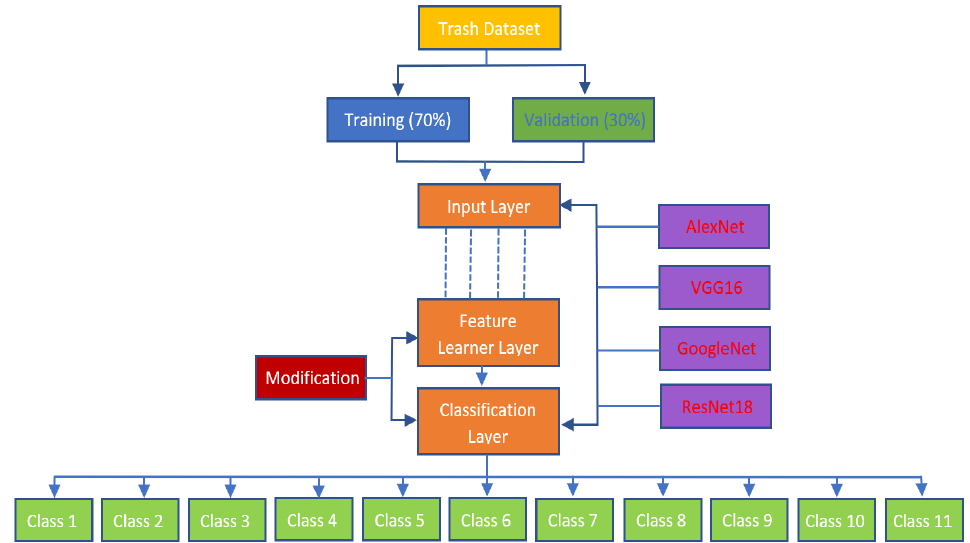
Figure 5. Simple transfer learning using CNN architecture (AlexNet, VGGG16, GooogleNet, and ResNet18).